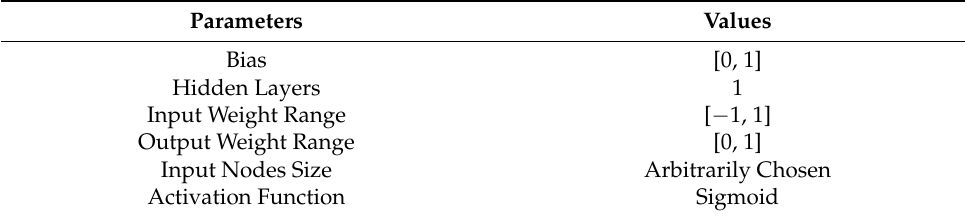
Table 3. Tuning Parameters of the ELM model.